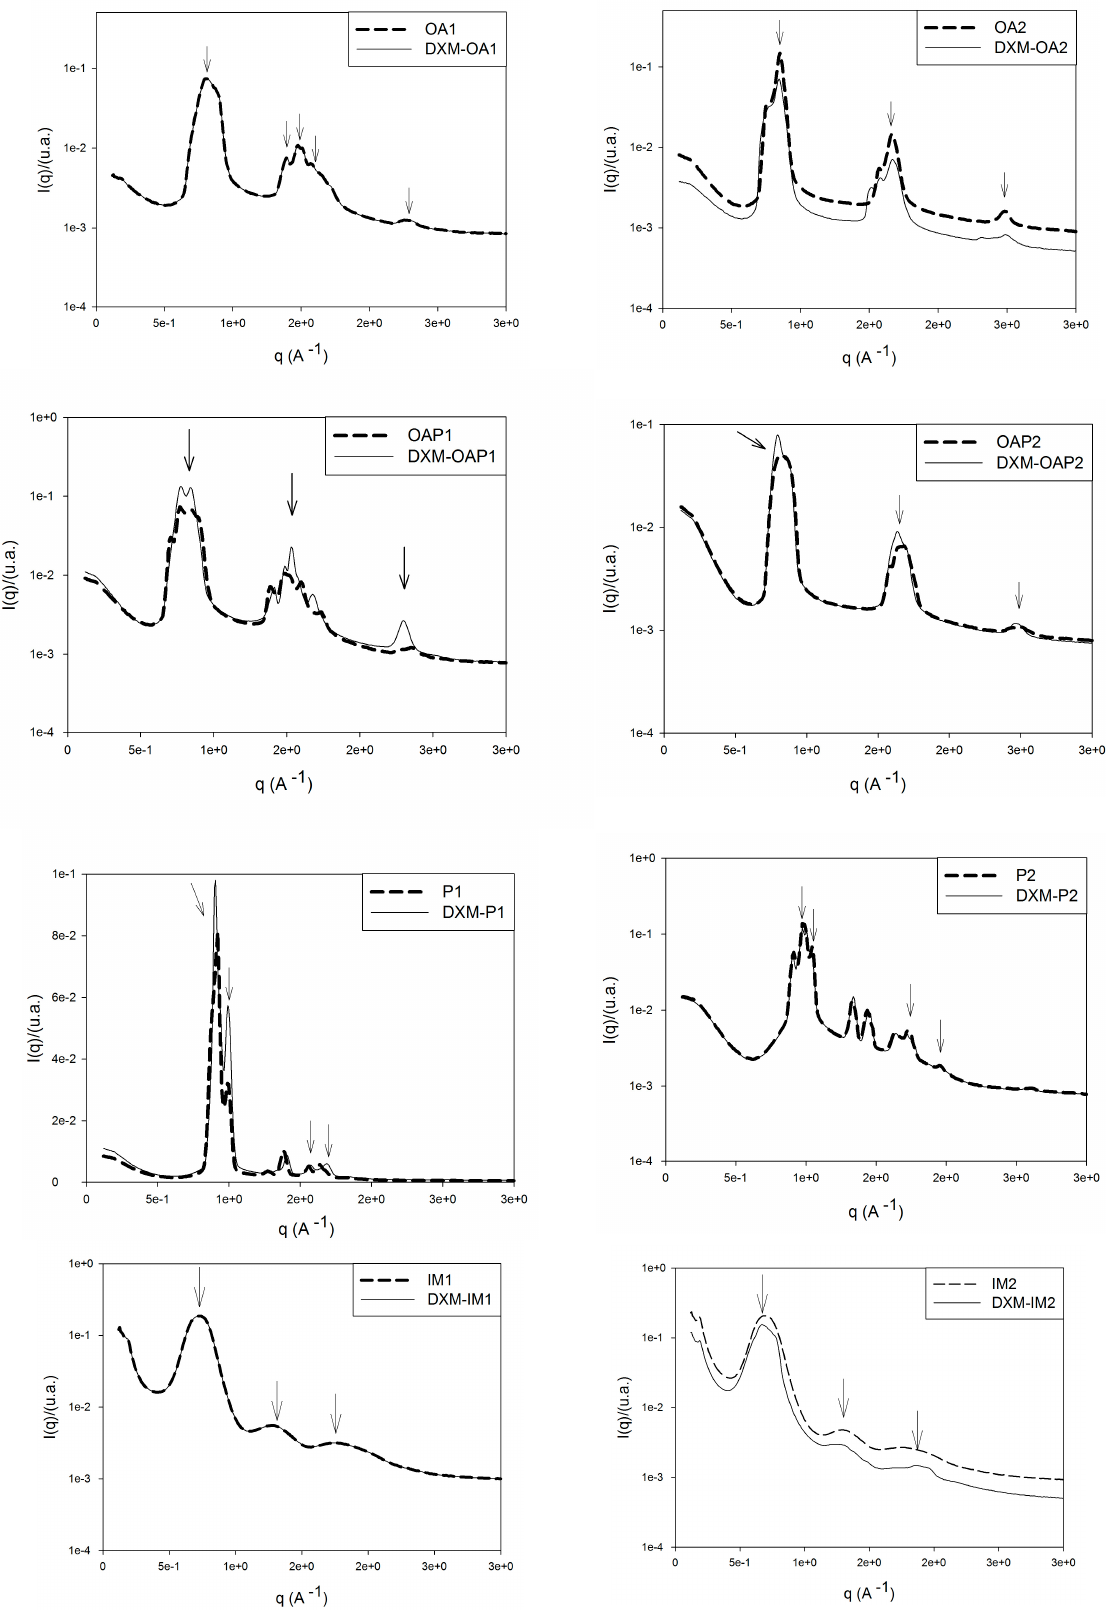
Figure 4. Small-angle X-ray scattering (SAXS) patterns of the formulations. The arrows indicate the considered peaks for the mesophase classifications.